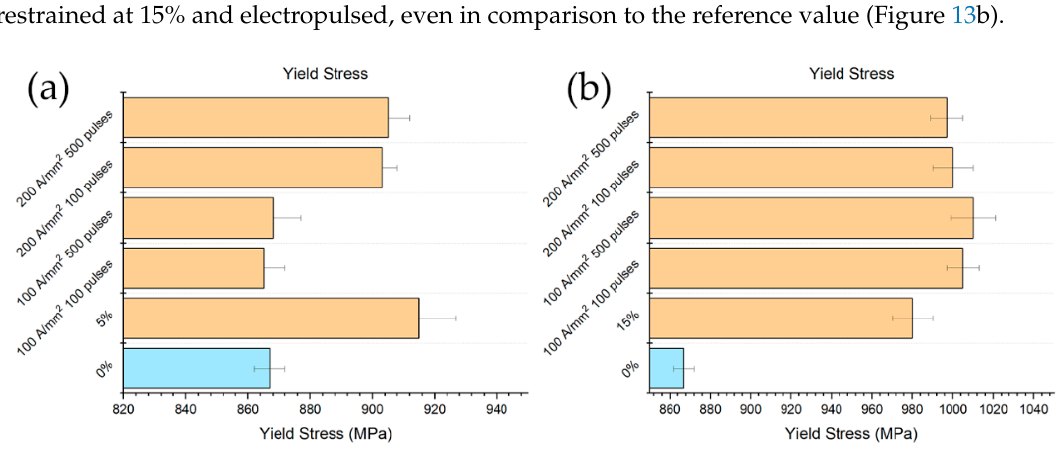
Figure 13. Evolution of YS with respect the different electropulsing treatments and references ( a ) 5% prestrained specimens and ( b ) 15% prestrained specimens.